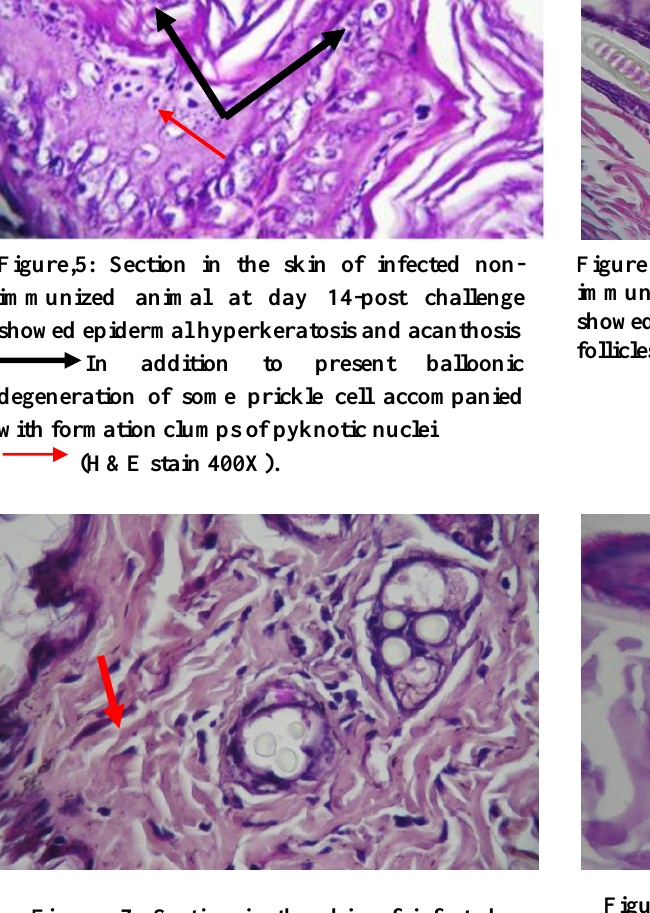
Figure, 7: Section in the skin of infected non- immunized animal at day 30 post challenge showed mononuclear cells infiltration around degenerated hair follicle (H&E stain 400X).